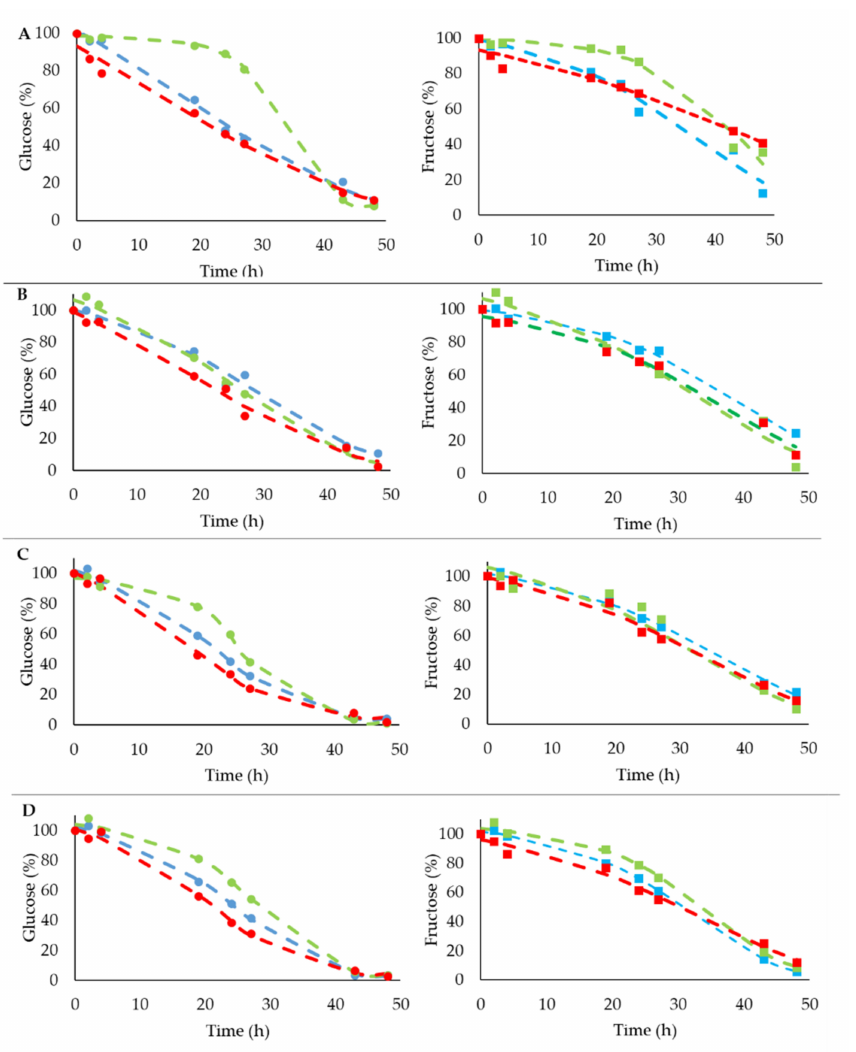
Figure 2. Observed and predicted with sigmoidal model (dashed lines) data related to glucose (left, circles symbols) and fructose (right, square symbols) by four strains after different pretreatments. ( A ) Strain coded 2, ( B ) strain coded 7, ( C ) strain coded 47, ( D ) strain coded S122. Type of pretreatments showed with different colors: blue—control, green—temperature, red—ethanol